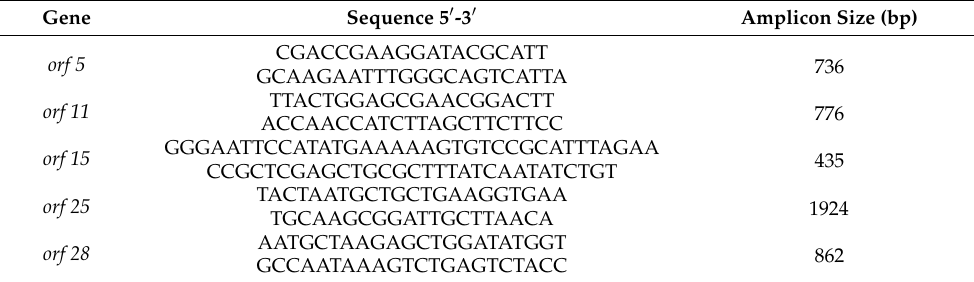
Table 3. Nucleotide sequence of primers used for PCR amplification of putative portal protein gene orf 5 , putative major capsid protein gene orf 11 , putative chloramphenicol resistant gene orf 15 , putative neck passage structure protein gene orf 25 , putative autolytic lysozyme gene orf 28 .